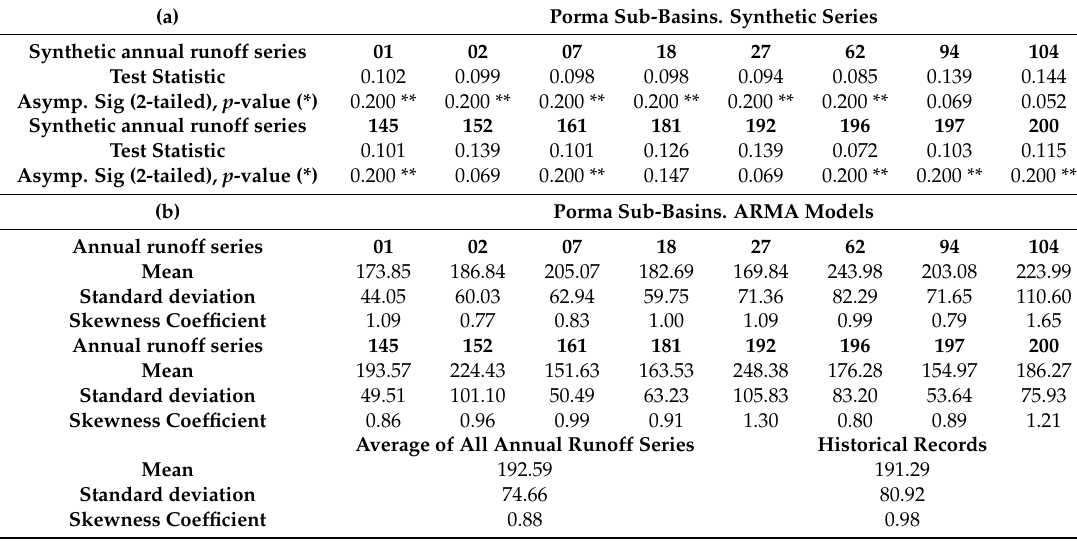
Table 1. Porma Sub-basin. ( a ) Goodness of fit results of synthetic series vs historical series made by Lilliefors corrected Kolmogorov–Smirnov test. Note: Test significance level ( α ) 5% ( p -value). (*) Lilliefors significance correction. ** Lower bound of the true significance; ( b ) Autoregressive Moving Average Model (ARMA)